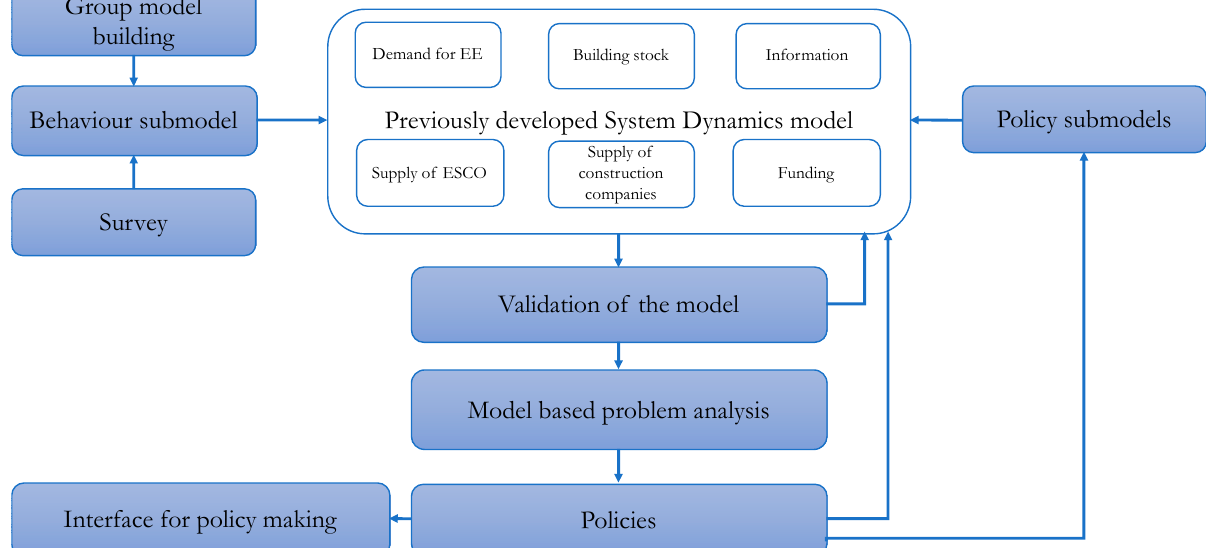
Figure 2. Methodology of the study (the dark-colored boxes present the scope of the study) (EE—energy efficiency; ESCO—energy service company).